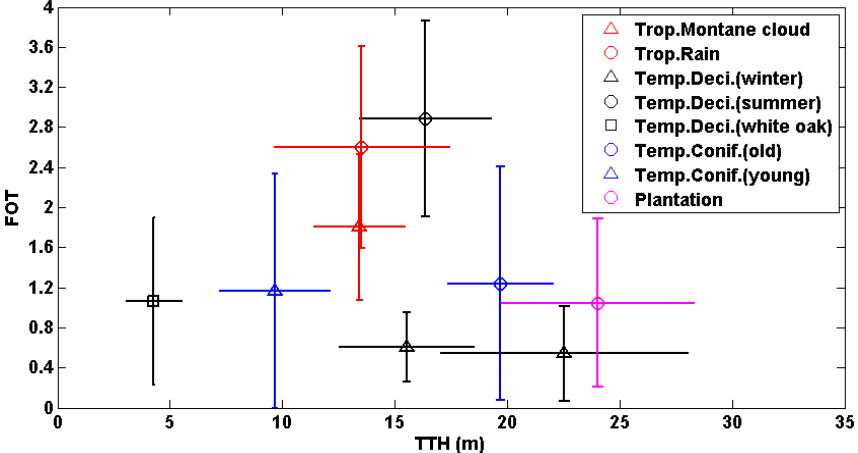
Figure 3. Mean (marker) and standard deviations (line segments) of lidar-derived forest optical thickness ( FOT ) and tree top height ( TTH ) for 9 forest plots. Trop.: tropical, Temp.: temperate, Deci.: Deciduous, Conif.: